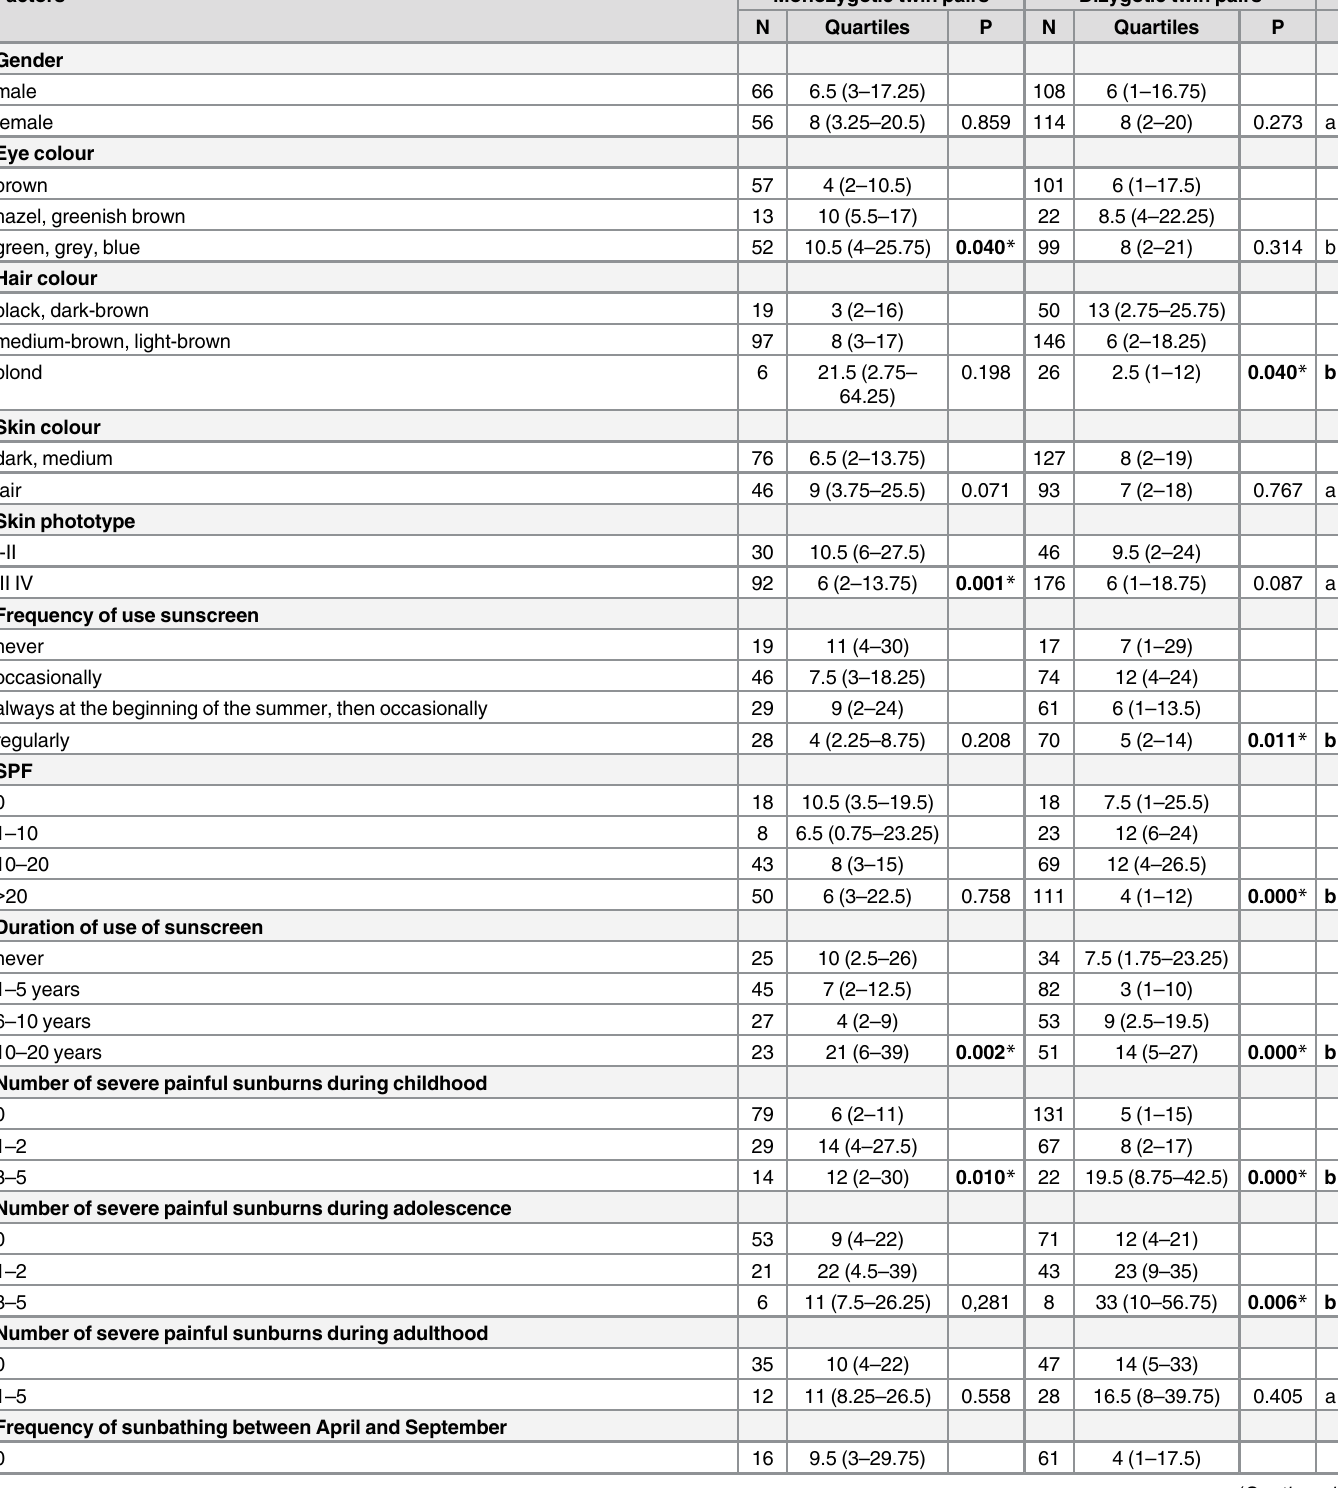
Table 3. Association between gender, constitutional and sun exposure variables and the prevalence of melanocytic naevi among monozygotic (N = 122) and dizygotic (N = 222) twin